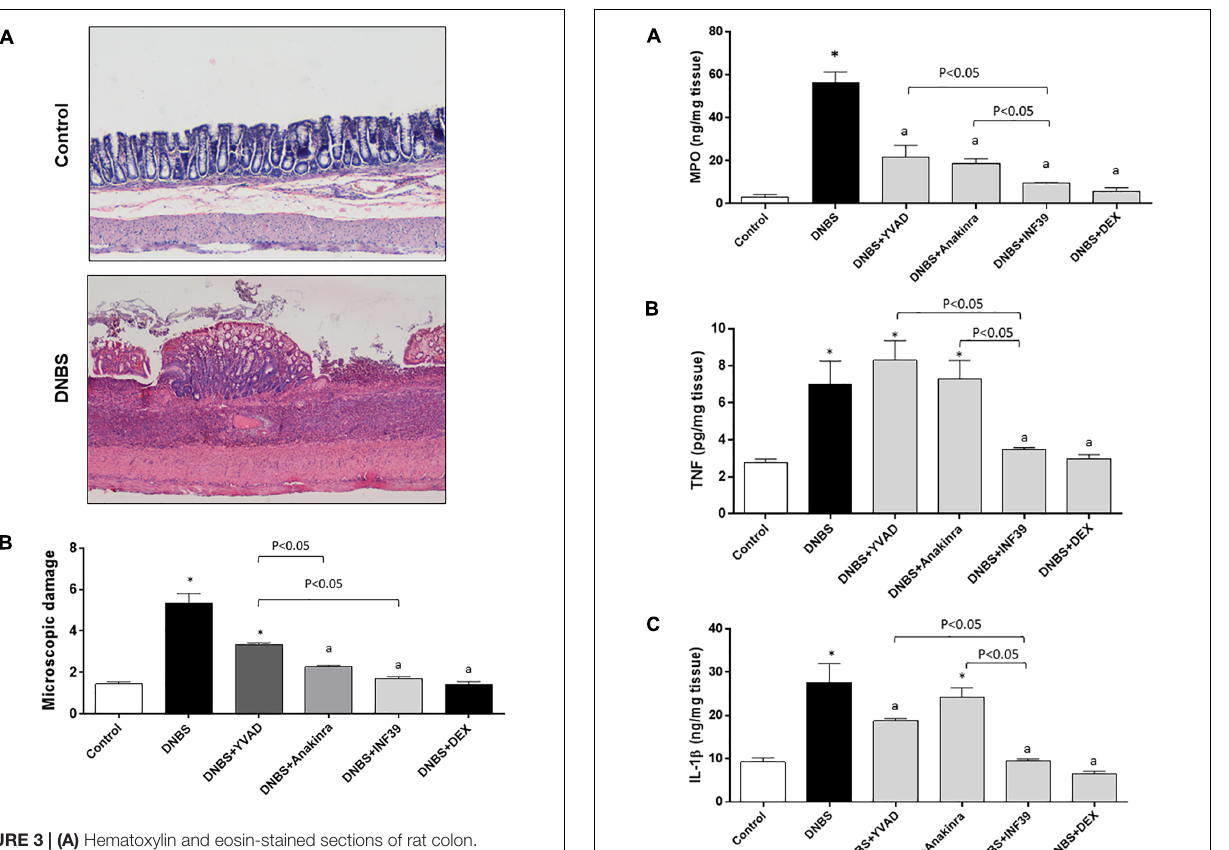
FIGURE 3 | (A) Hematoxylin and eosin-stained sections of rat colon. Representative microscopic images refer to control rats or animals with colitis induced by DNBS. (B) Microscopic damage score estimated for colon in rats under normal conditions or with DNBS-induced colitis, either alone or after treatment with Ac-YVAD-cmk (YVAD, 3 mg/Kg), anakinra (100 mg/Kg), INF39 (25 mg/kg) or DEX (1 mg/kg). Each column represents the mean ± S.E.M. ( n = 10). ∗ P < 0.05, significant difference vs. control group; a P < 0.05, significant difference vs. DNBS group.